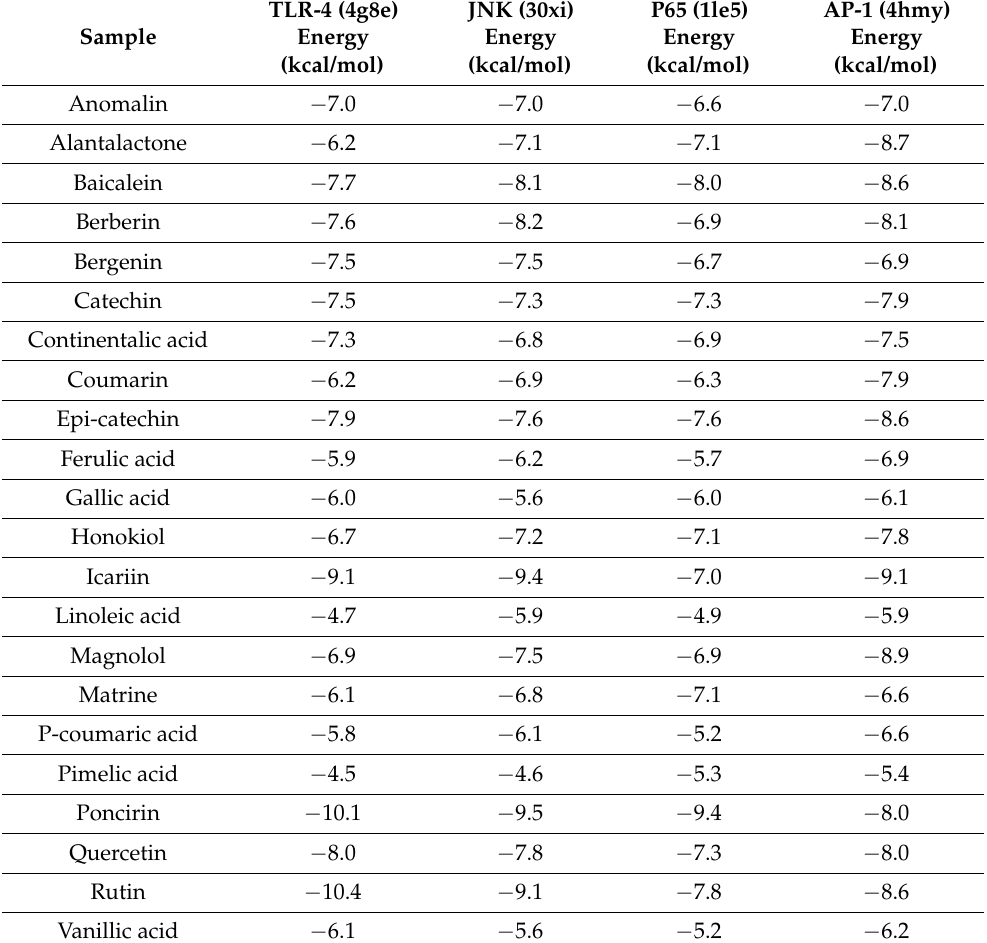
Table 5. The molecular docking score of the selected compounds against the TLR-4, JNK, NF- κ B, and AP-1